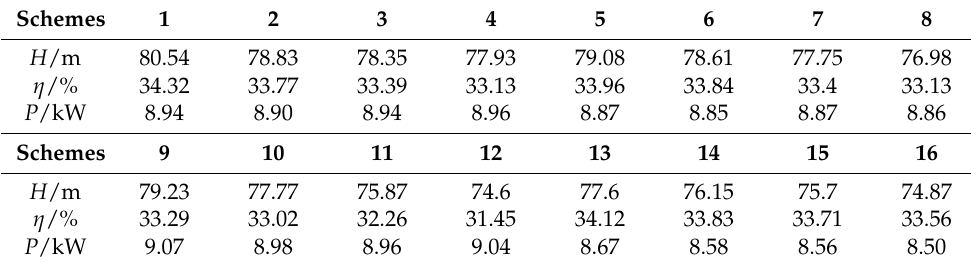
Table 5. Numerical simulation results at 1.4 Q des